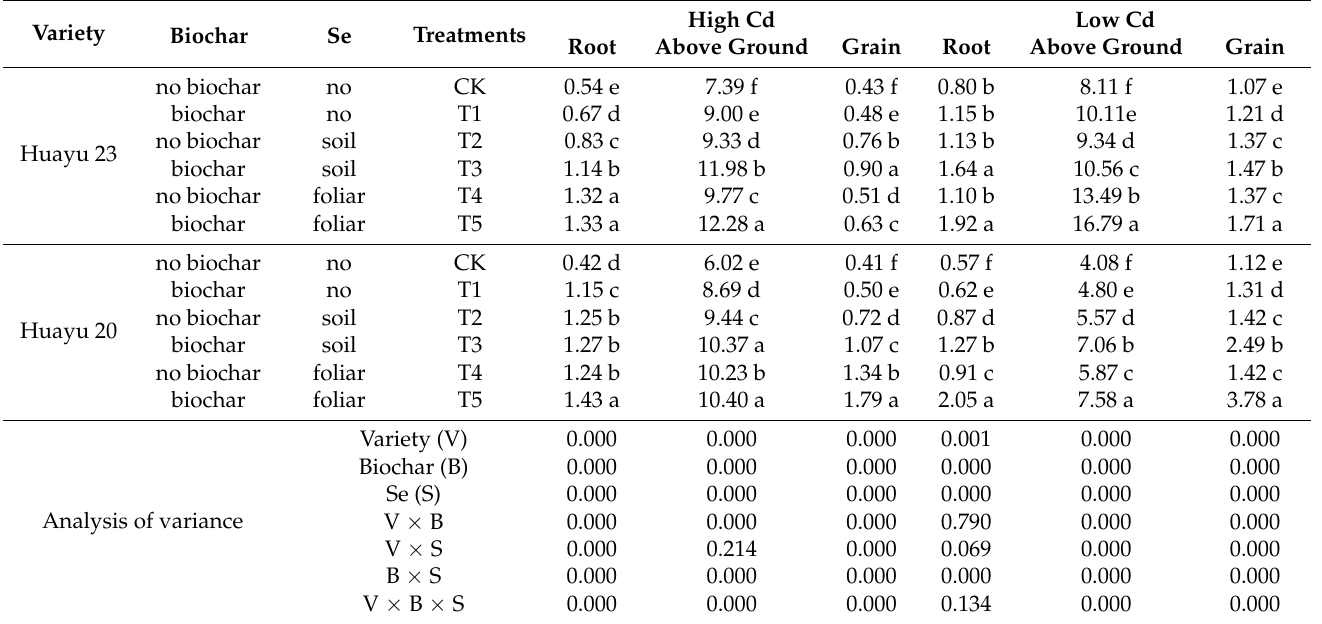
Table 1. Biomass (g) and grain yield (g) of roots and shoots of Huayu 23 and Huayu 20 under different